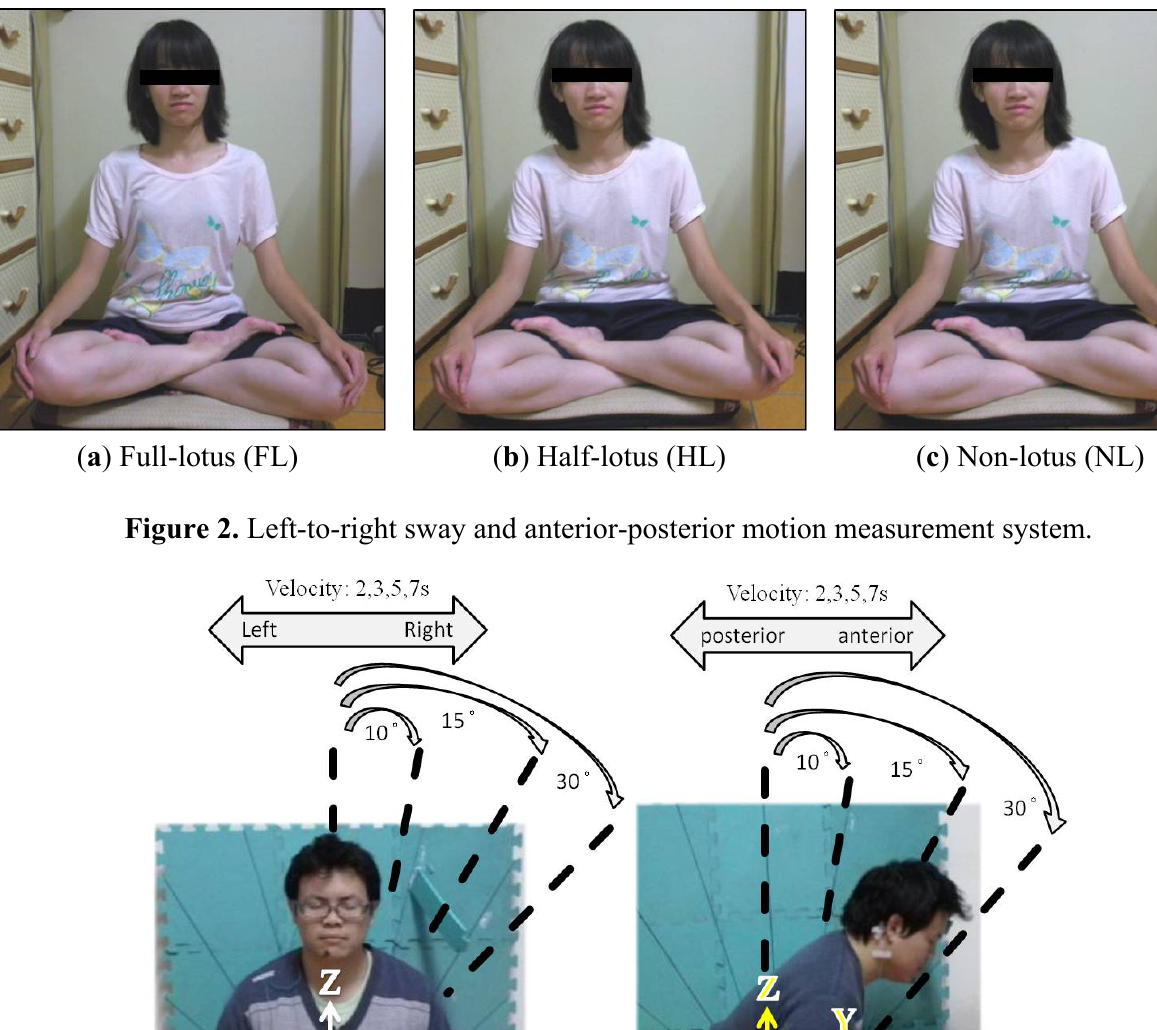
Figure 1. Three leg-crossing postures.